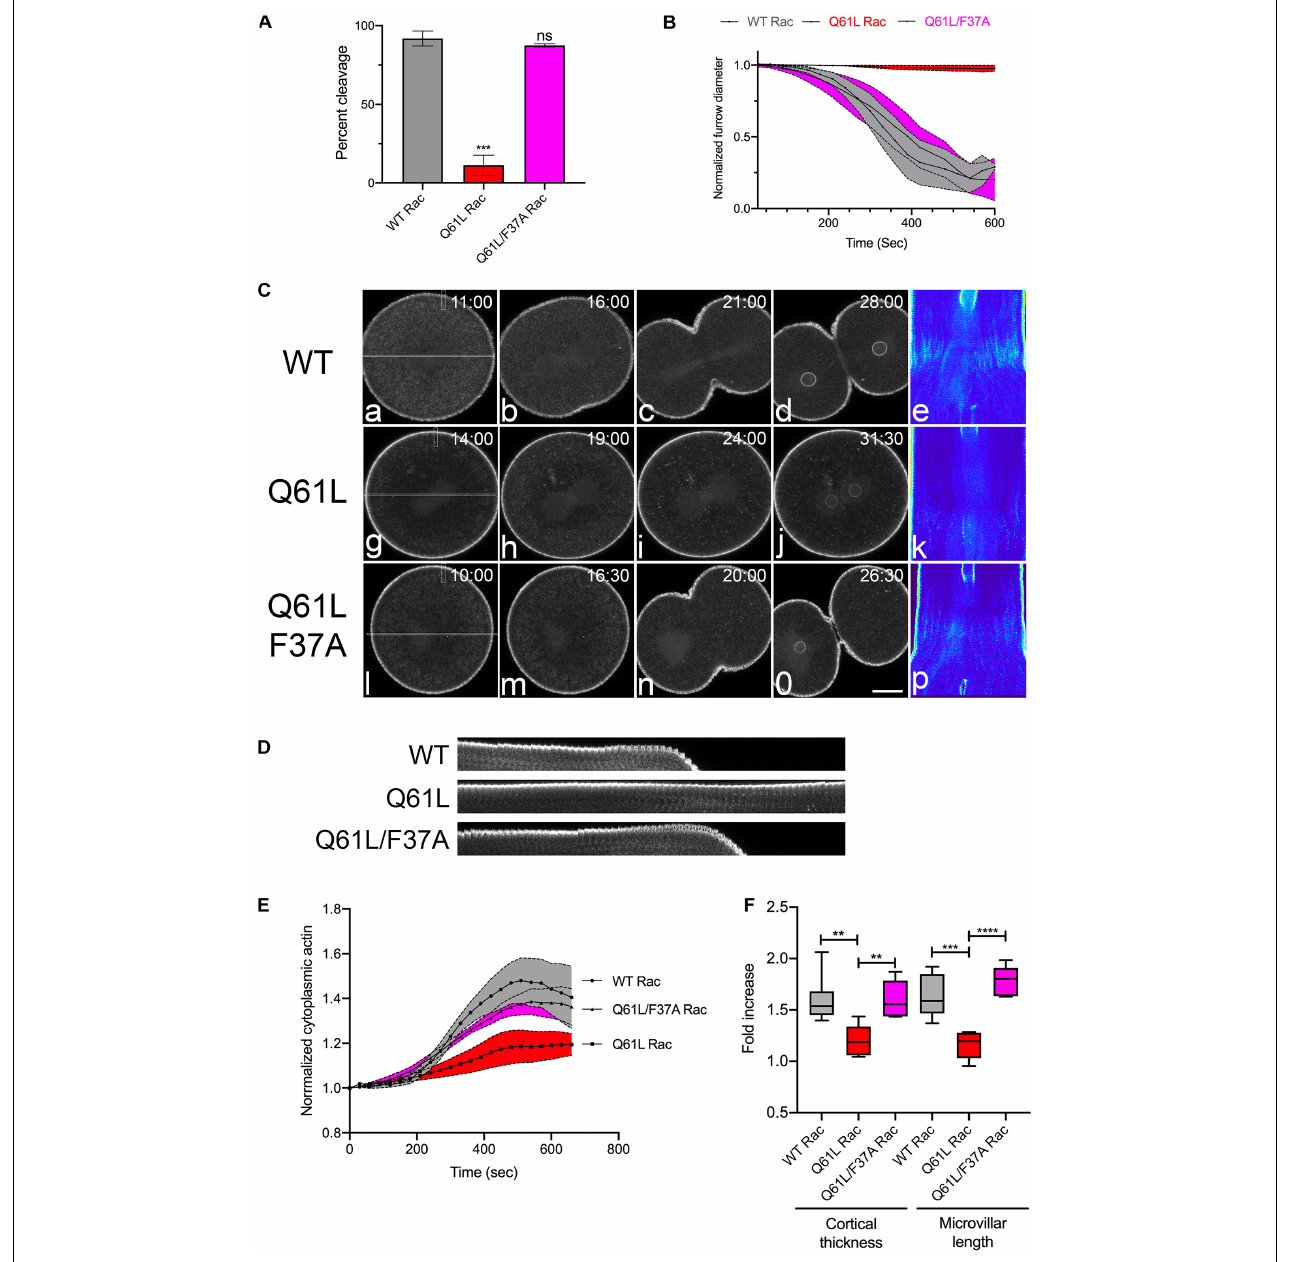
FIGURE 2 | Activated Rac suppresses actin dynamics and cytokinesis. (A) Cleavage rates for L. variegatus embryos injected with WT, Q61L or Q61L/F37A Rac mRNA (final intracellular concentration 2.5 µ g/ml) and recombinant Lifeact-GFP (final intracellular concentration 0.2 µ M) immediately after fertilization and cultured at 20 ◦ C until un-injected controls completed cytokinesis. Mean ± SEM for three experimental replicates, with > 21 cells per experiment. *** p < 0.001. (B) Furrow ingression profiles for injected cells, beginning at the initiation of furrowing (mean ± SEM, n = 5 per condition). (C) Frames from time-lapse movies of L. variegatus embryos injected with mRNA encoding WT or mutant Rac. Time points denote minutes post-NEB. Bar, 30 µ m. Rectangles in panels (a,g,l) denote the region used to generate the kymographs in panels (e,k,p) . Small rectangles denote regions used to generate the kymographs in panel (D) . Bar, 30 µ m. (D) Kymograph highlighting microvillar growth and cortical actin dynamics during mitotic exit in WT or mutant Rac-expressing cells. (E) Quantification of cytoplasmic actin levels beginning 1 min post-NEB up until the metaphase-anaphase transition (Mean ± SEM, n = 6 cells per condition). Activated Rac (Q61L, red) suppressed the increase in cytoplasmic actin in comparison to WT (gray), whereas activated Rac containing the effector-binding mutation F37A (Q61L/F37A, magenta) had no effect on cytoplasmic actin levels. (F) Quantitation of the increases in cortical thickness and microvillar length that accompanies the metaphase-anaphase transition in embryos expressing WT and mutant Rac ( n = 6 cells per condition, whiskers denote minimum and maximum values), where a value of 1.0 represents length or thickness 1 min prior to the metaphase-anaphase transition. Activated Rac blocked both cortical thickening and microvillar elongation, but these actin dynamics were rescued in embryos expressing the double mutant that is incapable of promoting WAVE-mediated Arp2/3 activation. ** p < 0.005, **** p < 0.0001.